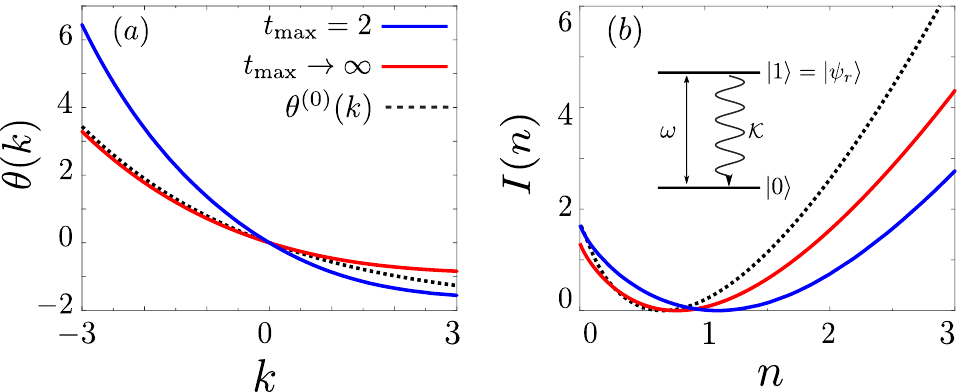
〉 = | 1 〉 . (a) Scaled cumulant Figure 4: Two-level system reset to the active state | ψ r = 2 (in units of ω − 1 , blue solid generating function θ ( k ) as a function of k for t max → ∞ (red solid line). The SCGF of the reset-free dissipative process line) and t max θ ( 0 ) ( k ) is shown as a black dashed curve for comparison. (b) Rate function I ( n ) as a function of the activity n = N / t for the same values of t as in panel (a). The two- max level system is also sketched. Resetting favours the population of the active state | 1 〉 and therefore, contrarily to Fig. 2, enhances the activity of the system. In the Figure we set γ = 0.3 and K = 4 in units of ω